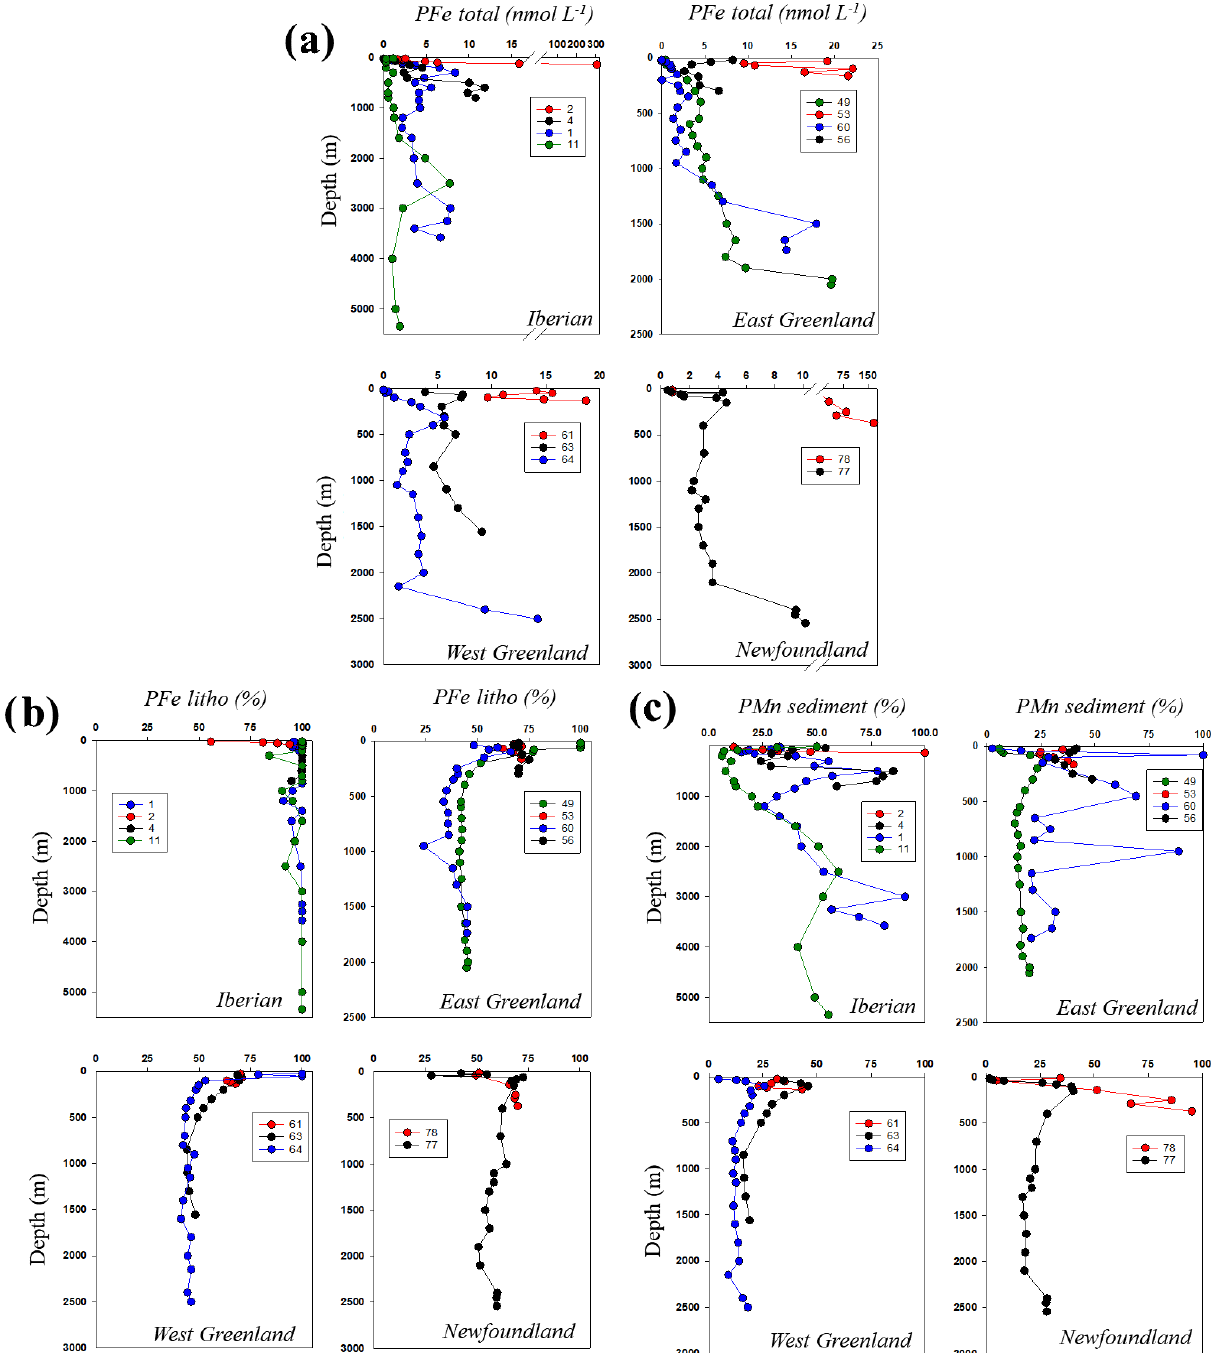
Figure 8. Vertical profiles of (a) PFe (nmolL − 1 ), (b) lithogenic proportion of particulate iron (PFe litho , %), and (c) sedimentary proportion of particulate manganese (PMn sediment, %) at the Iberian, East–West Greenland, and Newfoundland margins.